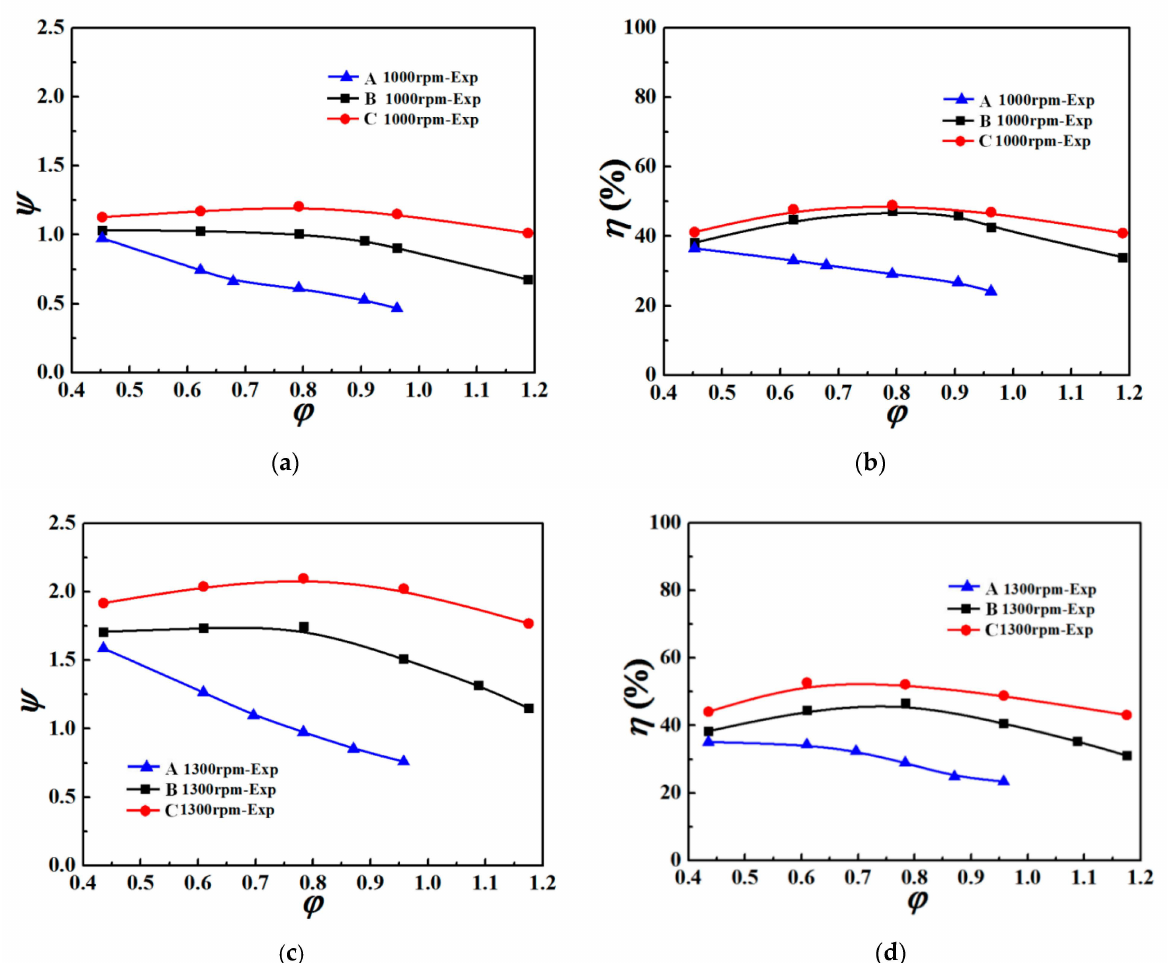
Figure 5. Aerodynamic performances of fans with different blades. ( a ) Coefficients of the total pressure and flow at 1000 rpm, ( b ) coefficients of the efficiency and flow at 1000 rpm, ( c ) coefficients of the total pressure and flow at 1300 rpm, and ( d ) coefficients of the efficiency and flow at 1300